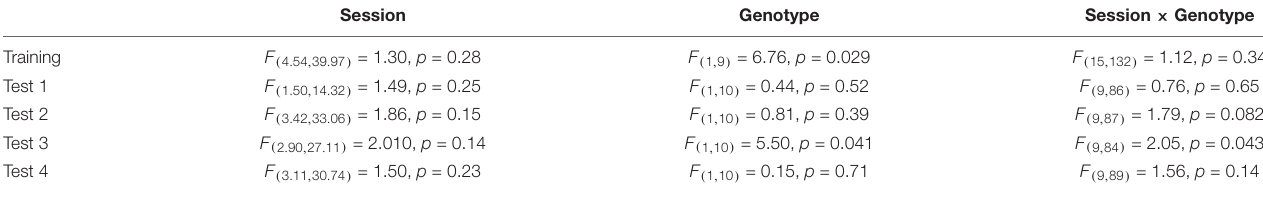
TABLE 3 | Choice reaction